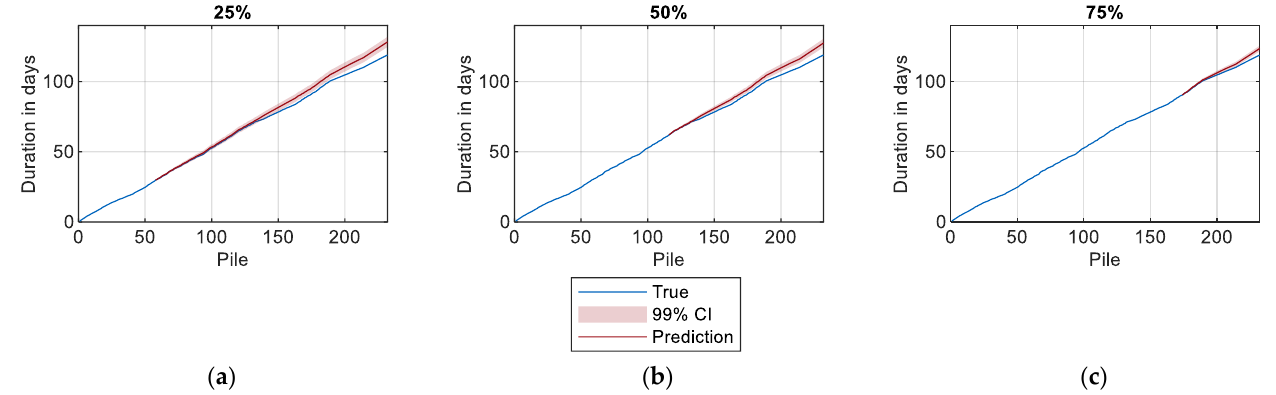
Figure 13. Cumulative duration of pile production during the construction project: as-built (blue) vs. as-predicted by the simulation runs (red) based on ( a ) 25%, ( b ) 50%, and ( c ) 75% as-built data (CI: confidence interval).